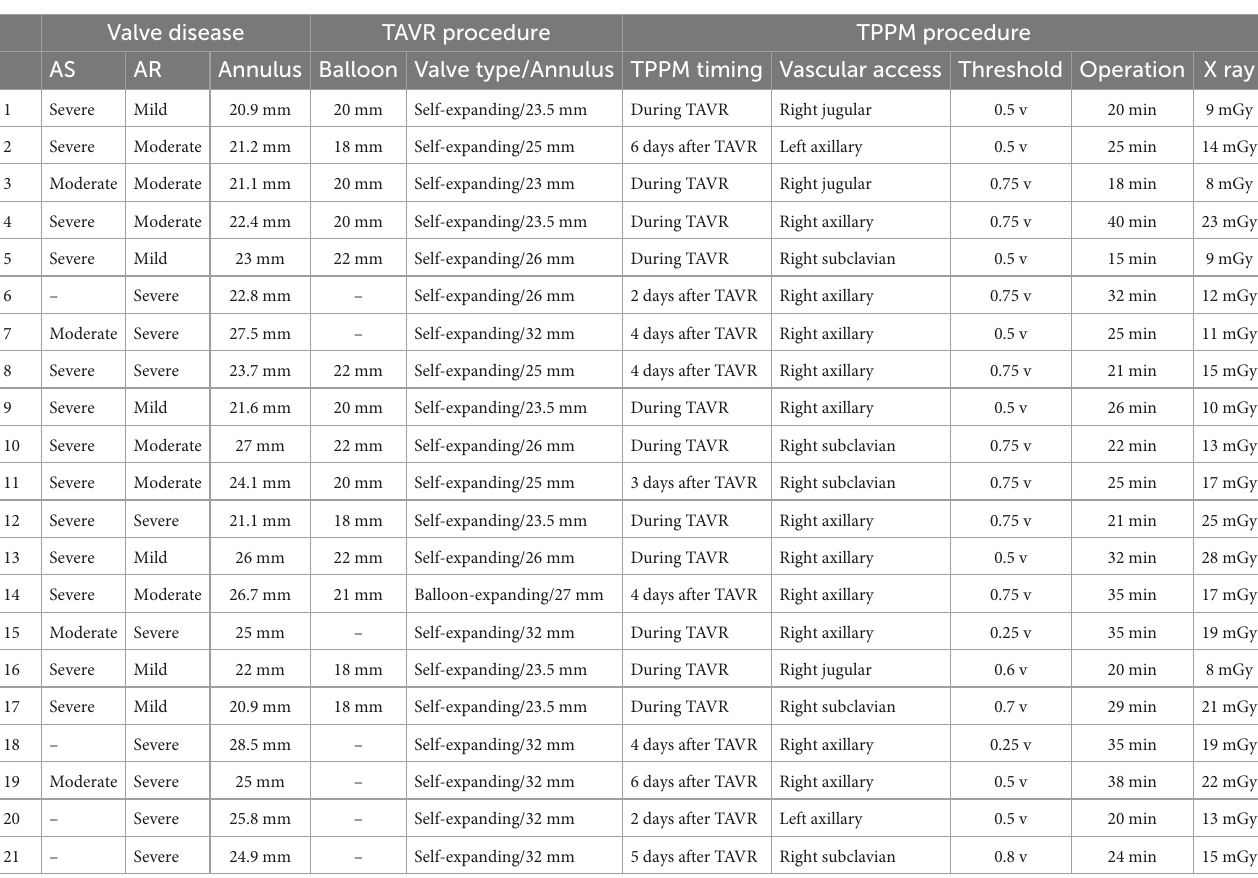
TABLE 2 Transcatheter aortic valve replacement (TAVR) and temporary permanent pacemaker (TPPM) procedure characteristics of each patient. Valve disease TAVR procedure TPPM